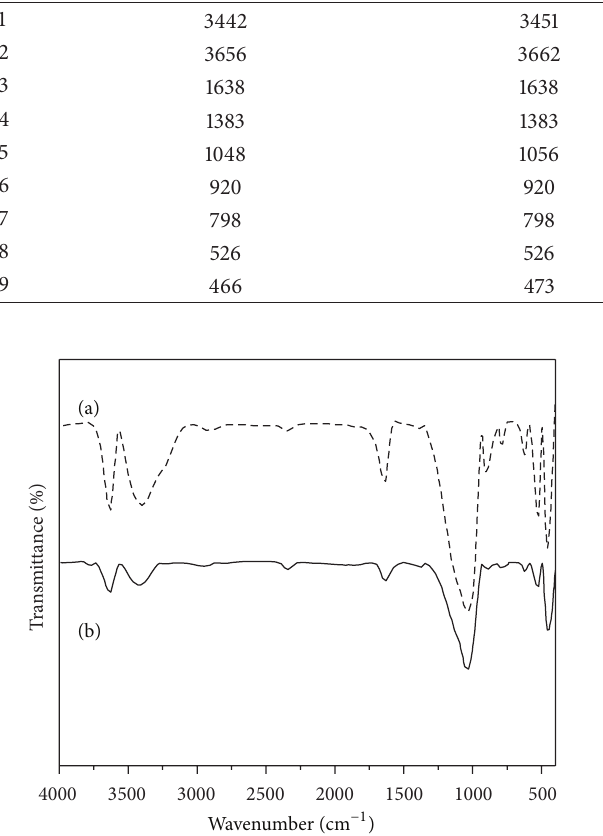
Figure 2: FTIR spectra of (a) CCB before adsorption and (b) CCB after